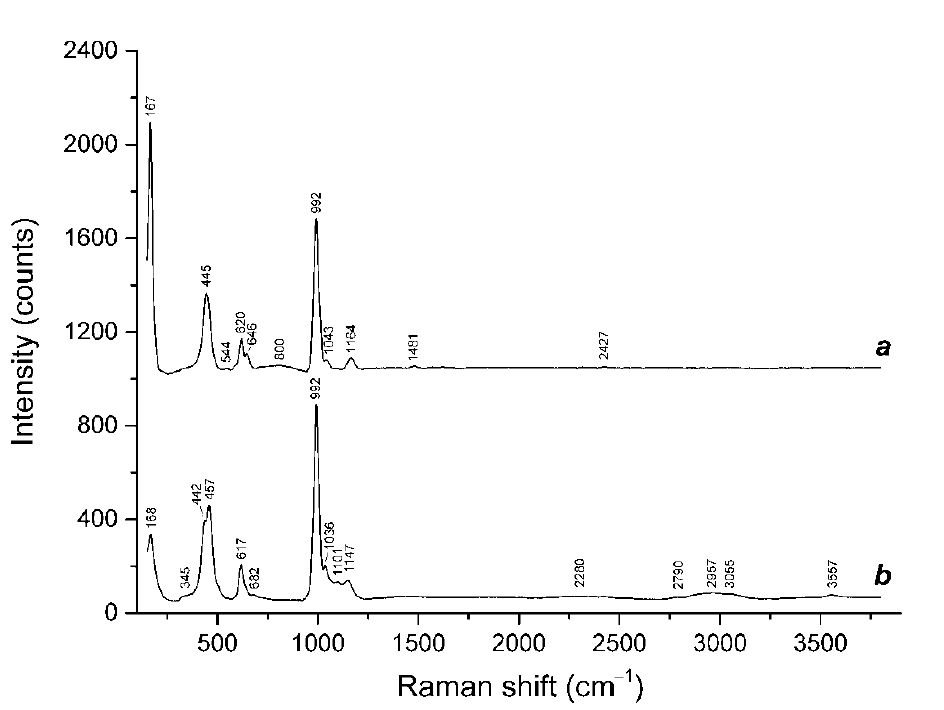
Figure 19. Raman spectra of ( a ) franzinite, Sample 14, and ( b ) marinellite, Sample